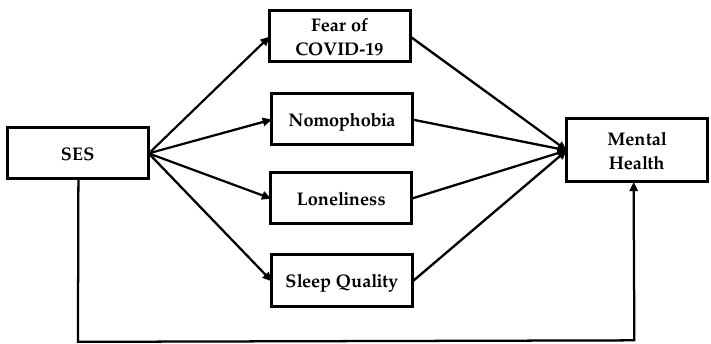
Figure 1. Research Figure 1. Research framework.